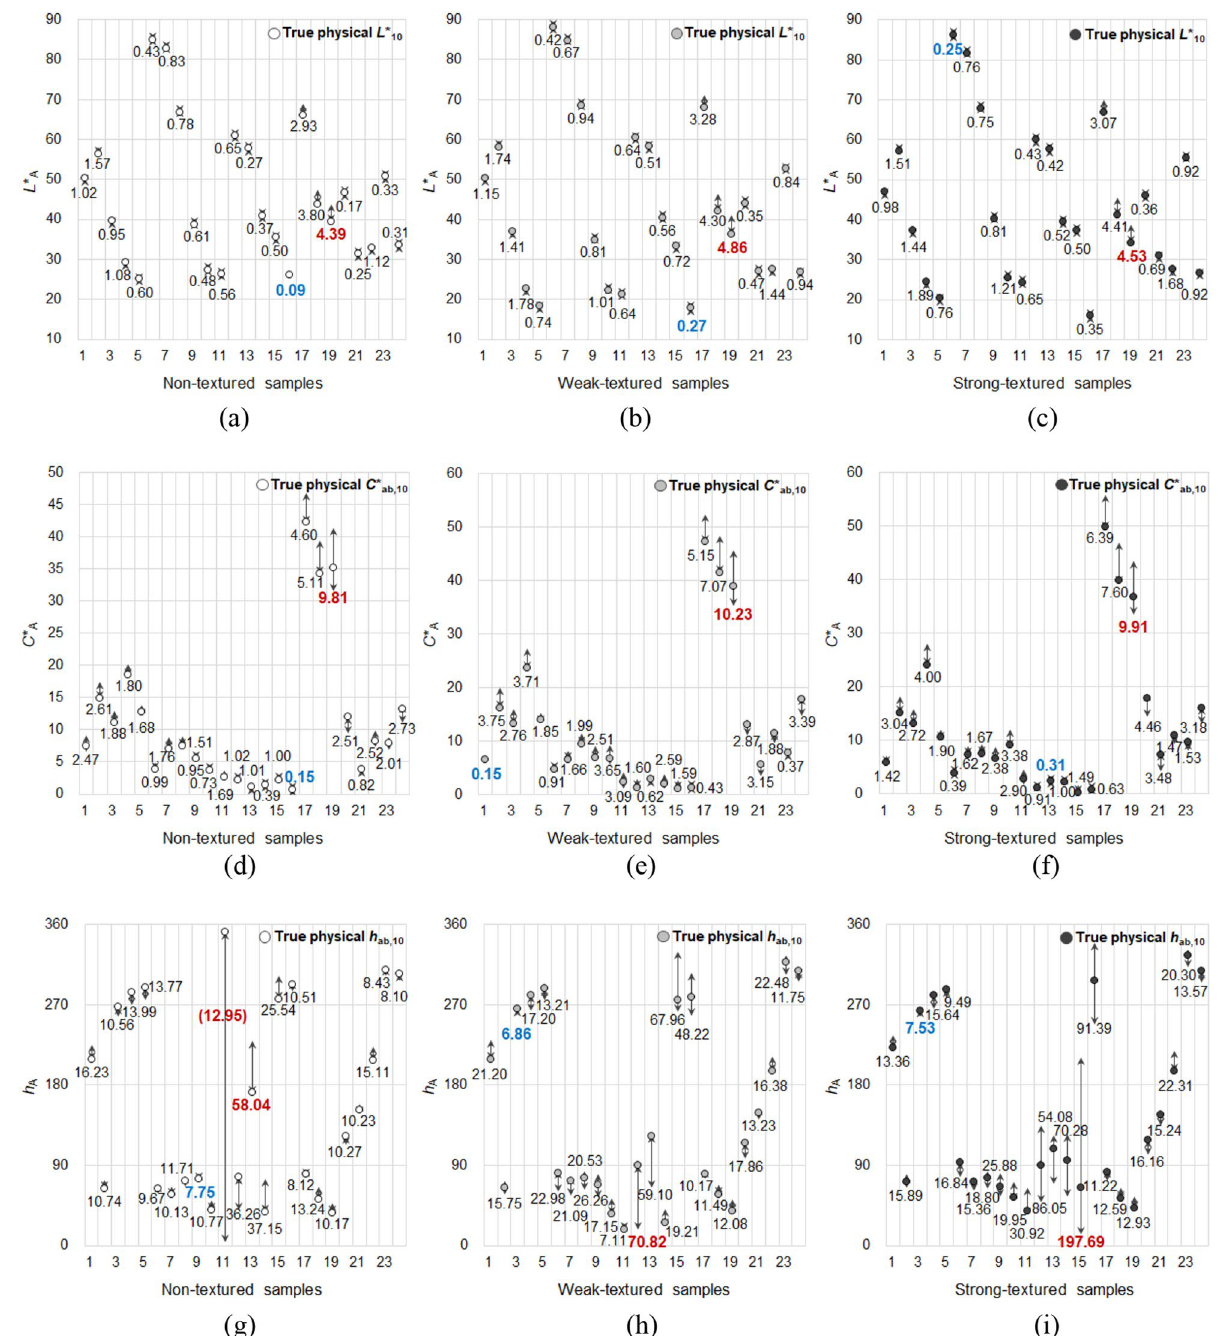
Figure 5. Ranges of the color appearances of samples with different surface texture strengths that vary under four different standard illuminants: ( a ) L * A ranges of non-textured samples, ( b ) L * A ranges of weak-textured samples, ( c ) L * A ranges of strong-textured samples, ( d ) C * A ranges of non-textured samples, ( e ) C * A ranges of weak-textured samples, ( f ) C * A ranges of strong-textured samples, ( g ) h A ranges of non-textured samples, ( h ) h A ranges of weak-textured samples, and ( i ) h A ranges of strong-textured indicating that the lightness and chroma appearances of the color varied most considerably depending on the illu- minant. On the other hand, as for the hue appearance of samples, the color center with the largest hue appearance range depended on the texture strength of the sample—that is, the 13th, 12th, and 15th color centers for non- textured, weak-textured, and strong-textured sample sets, respectively. However, in the case of textured fabric samples, the color centers which had the largest hue appearance ranges, that is, the 12th and 15th color centers (of which physical h ab,10 were 89.99 and 64.41, respectively), were both close to yellow. All these results indicate that the magnitude of the illumination effect on the color appearance changes of samples varied depending not